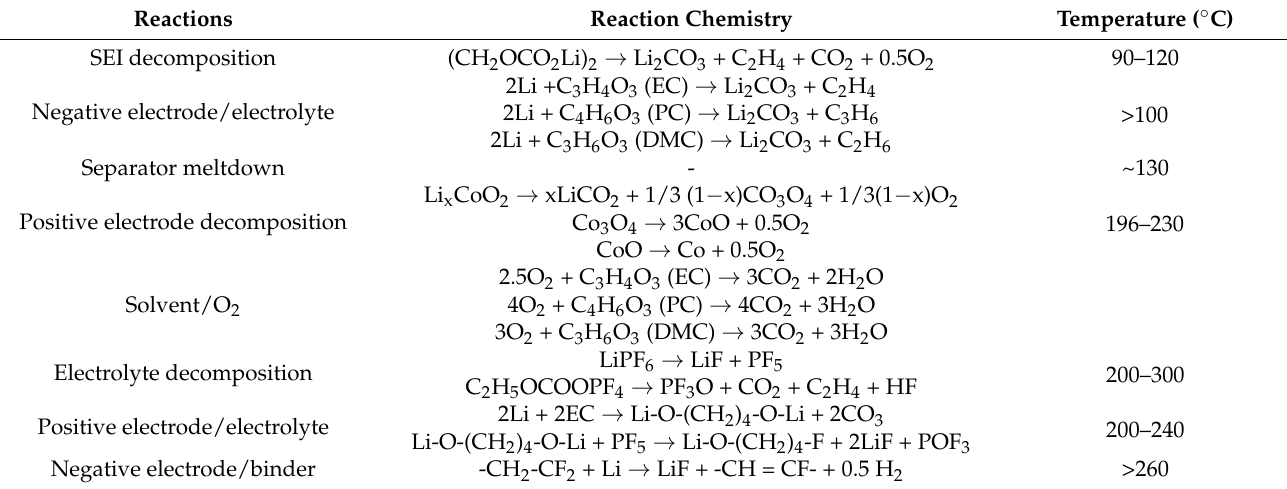
Table 1. Reactions relevant to Li-on battery thermal runaway [15,16]. Copyright 2012 Elsevier.